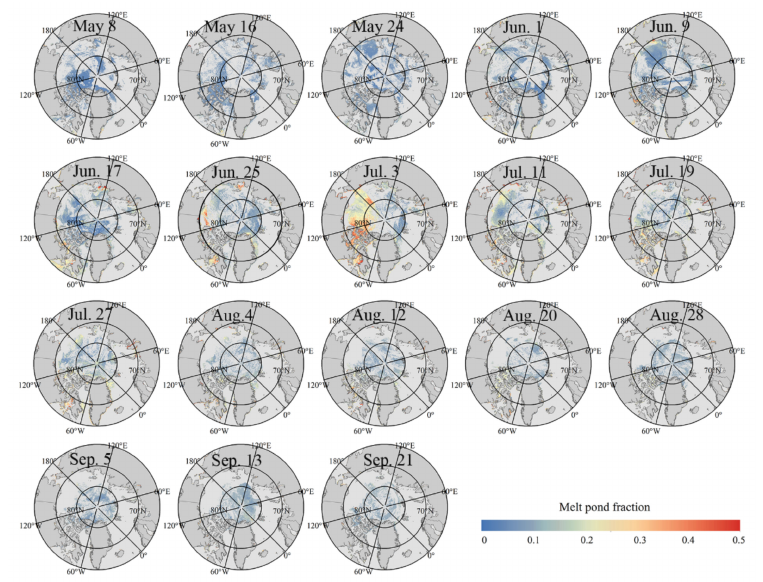
Figure 9. MPF dataset for Arctic sea ice without gap-filling (raw data derived using the GA-BPNN model) in 2017. For brevity, only the MPFs every eight days from 8 May to 24 September 2017, are shown, and the light grey color indicates the missing data due to cloud obscuration.